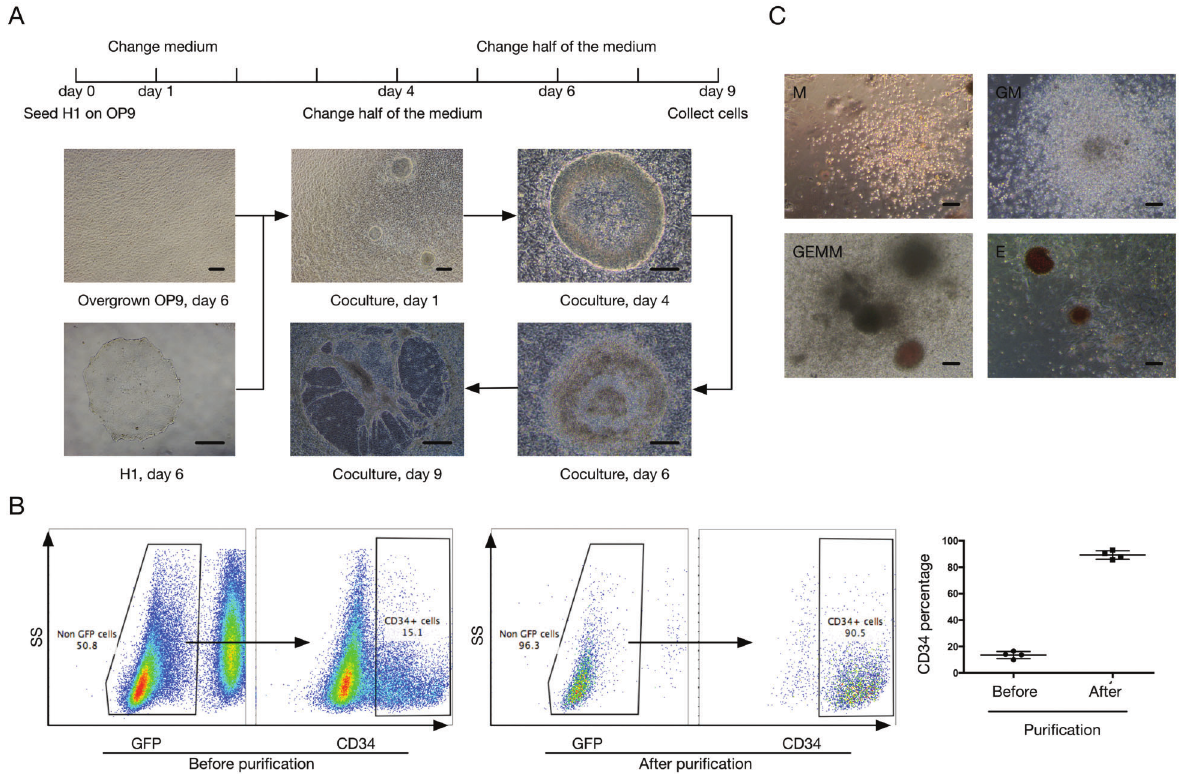
Figure 1. Hematopoietic differentiation of H1 cells in human pluripotent stem cells (hPSCs)/OP9 coculture system. A, Process fl ow diagram of hematopoietic differentiation in hPSCs/OP9 coculture system. Day 6 H1 were seeded on day 6 OP9. Morphological change of H1 clones is shown below. Scale bar=300 m m. B, The differentiated cells collected at day 9 were analyzed by fl ow cytometry. CD34 + cells were highly enriched by magnetic cell sorting (from 13.53 ± 1.34 to 89.25 ± 1.60%). C, Morphology of different colony-forming unit types, including M, GM, GEMM, and E. Scale bar=100 m